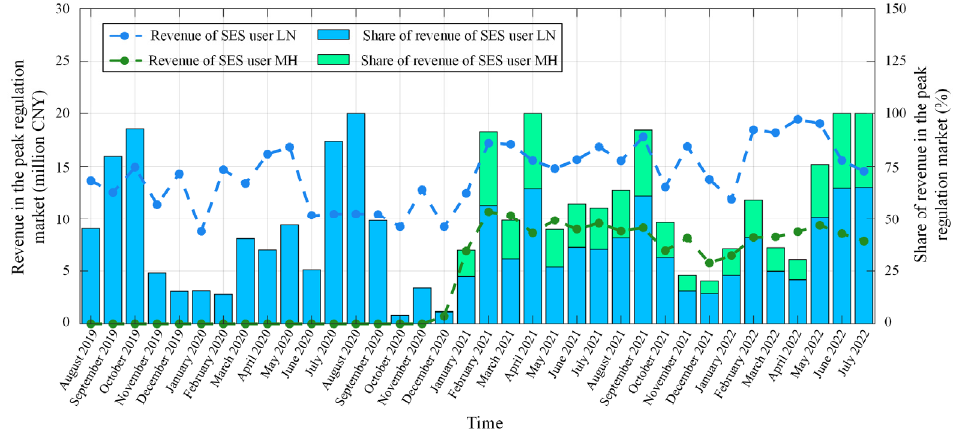
Figure 12. Revenue and its share of SES users in the peak-regulation ancillary service market in Qinghai, China.